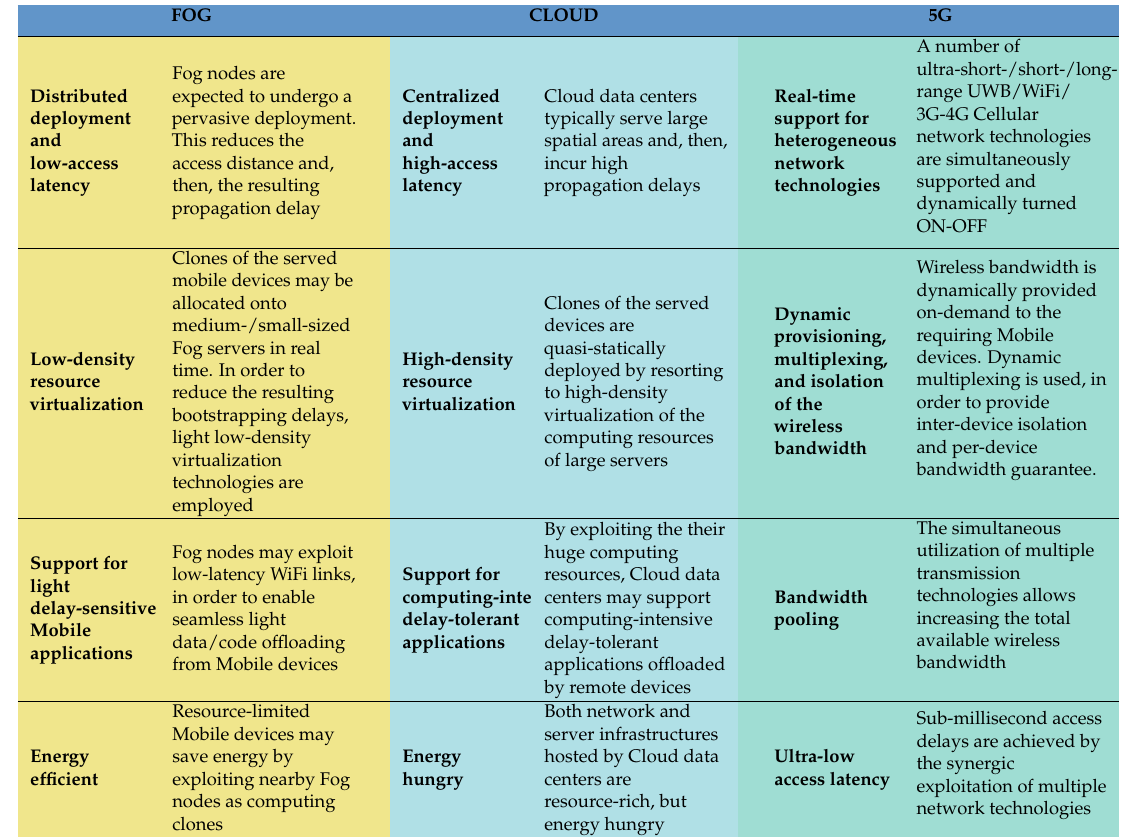
Table 1. The expected Fog-Cloud-5G synergic interplay for the support of future computing-intensive and delay-critical Mobile